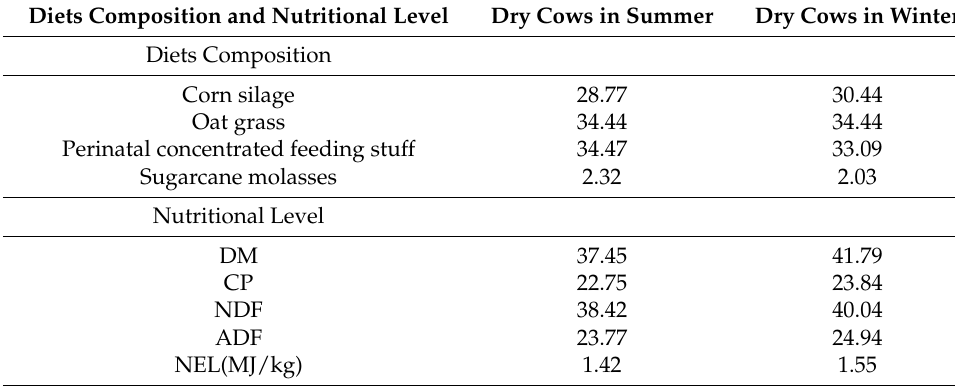
Table 1. Test diet composition and nutritional level (%, dry matter basis). Diets Composition and Nutritional